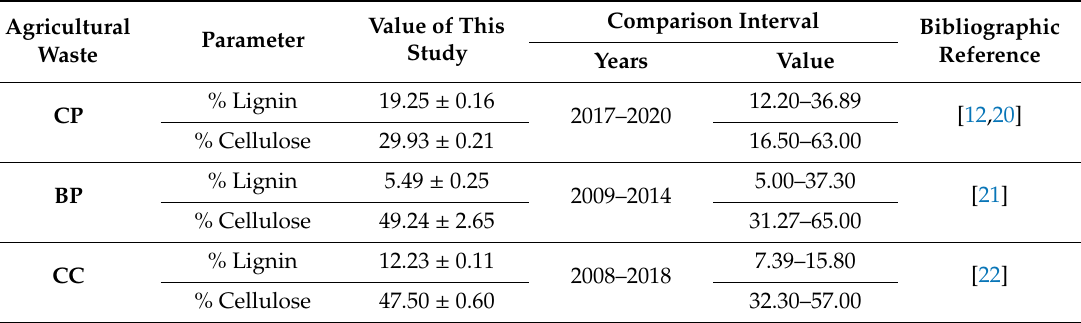
Table 1. Lignin and cellulose content in CP, BP, and